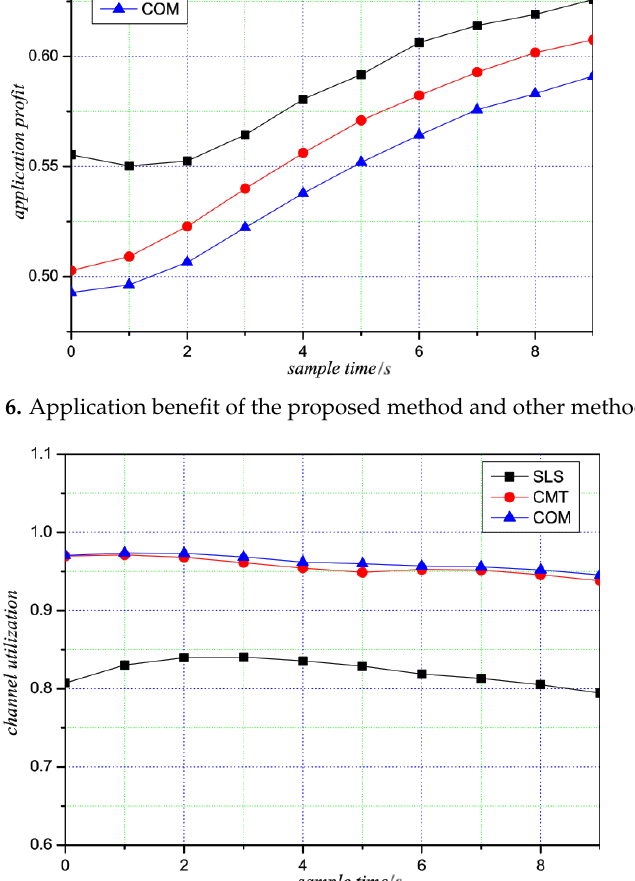
Figure 7. Channel utilization of the proposed method and other methods.